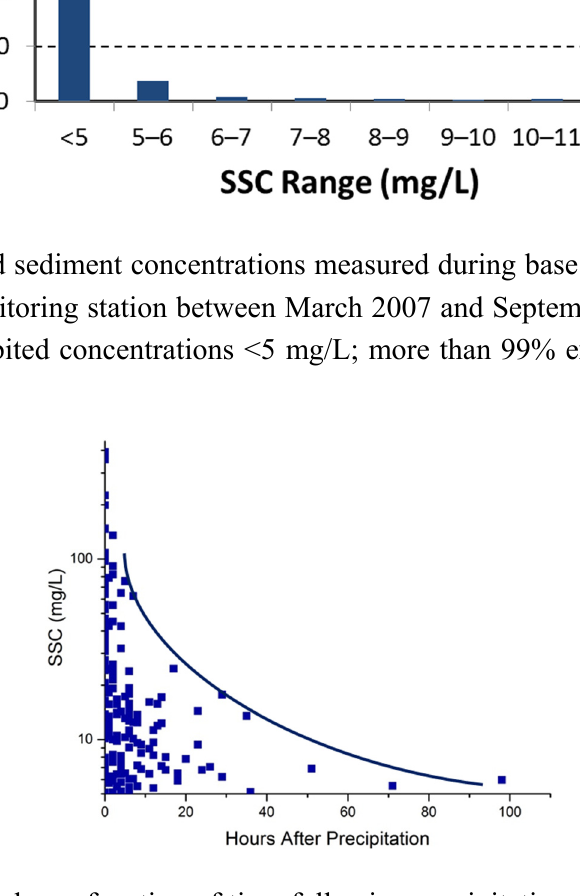
Figure 5. SSC plotted as a function of time following precipitation for the Allen Creek #1 monitoring site. Based on 69 events analyzed between March 2007 and July